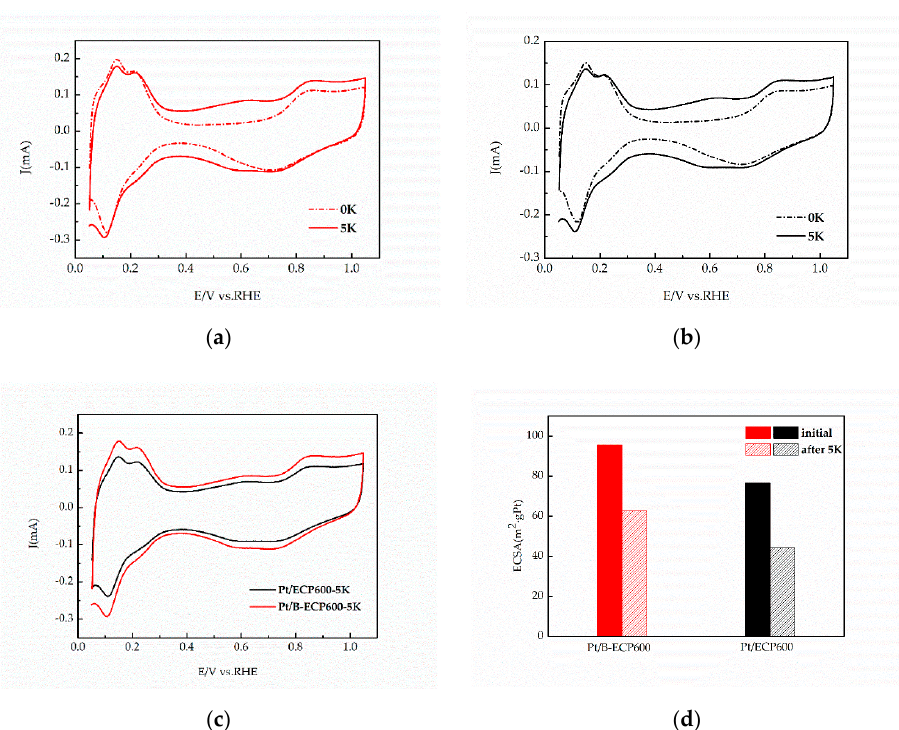
Figure 6. Electrocatalytic durability of carbon supports. CV curves of ( a ) Pt/B-ECP600 and ( b ) Pt/ECP600 before and after 5 K cycles of accelerated durability tests (ADTs); ( c ) CV curves of Pt/B- ECP600 and Pt/ECP600 after 5 K cycles of ADTs; and ( d ) ECSAs of Pt/B-ECP600 and Pt/ECP600 before and after 5 K cycles of ADTs.